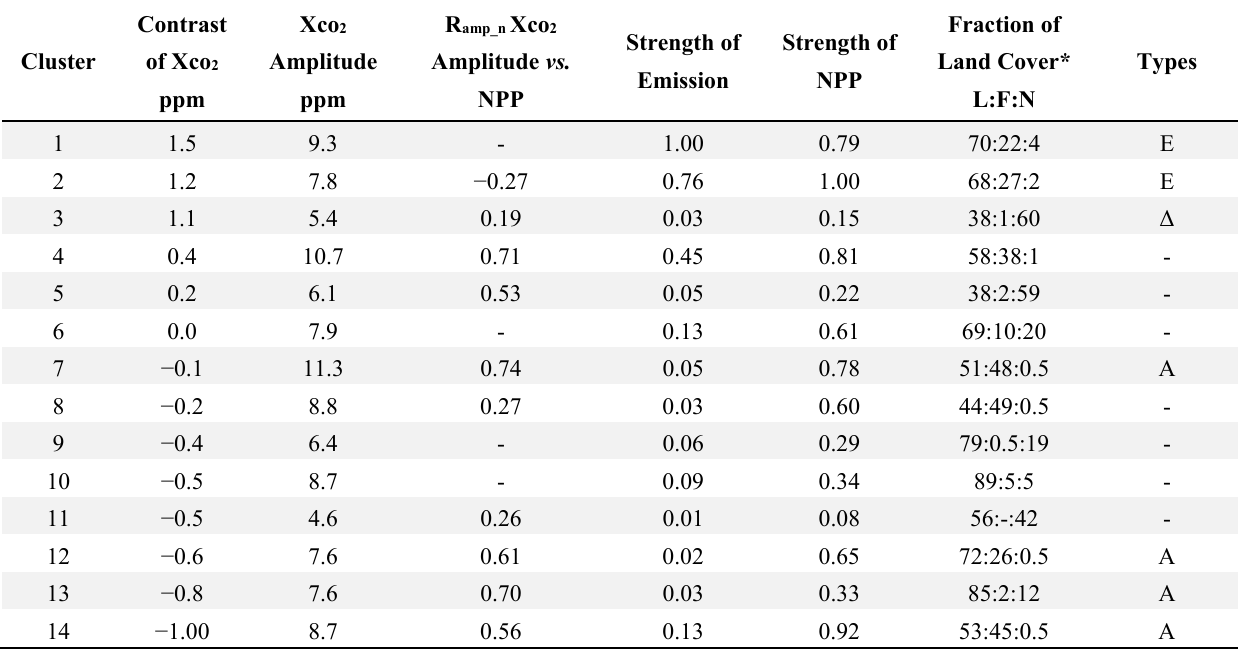
Table 1. Attribute characteristics of each cluster from the 2010